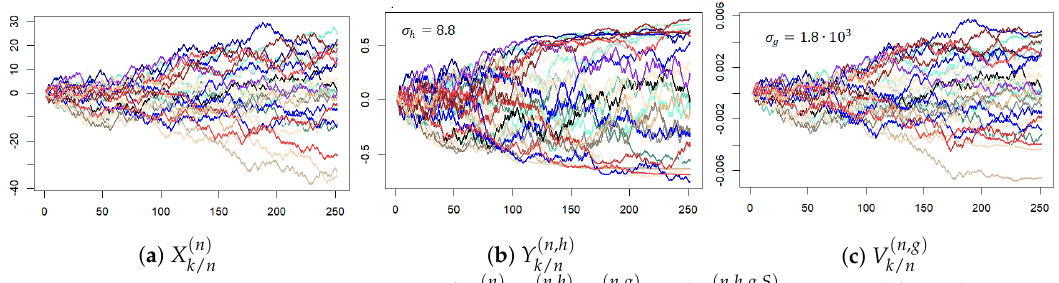
Figure A1. One-year times series traces of X 500 data.